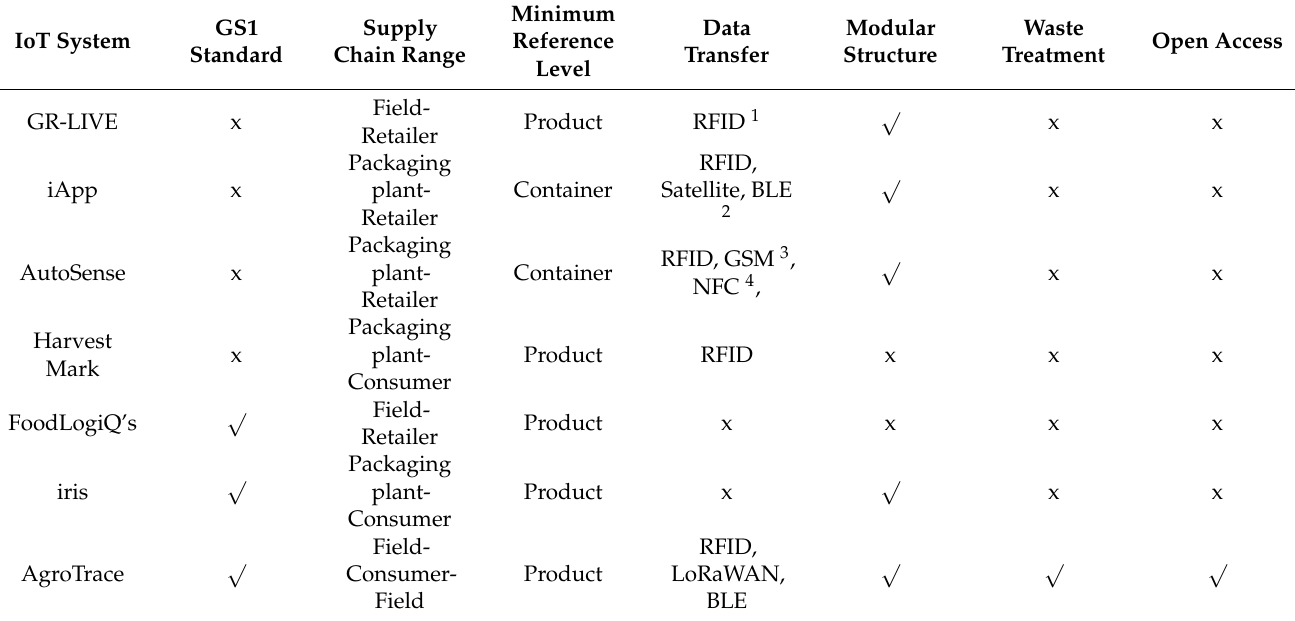
Table 1. Comparison of the available IoT-based traceability systems on the market with the proposed solution (AgroTRACE).